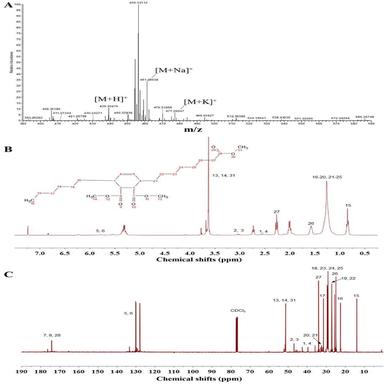
(A) ESI-MS, (B) 1 H NMR (400 MHz, CDCl3), and (C) 13C NMR (100 MHz, CDCl3) spectra of C22TAE. C22TAE, 22-carbon tricarboxylic ester; ESI-MS, electrospray ionization-mass spectrometry; NMR, nuclear magnetic resonance.